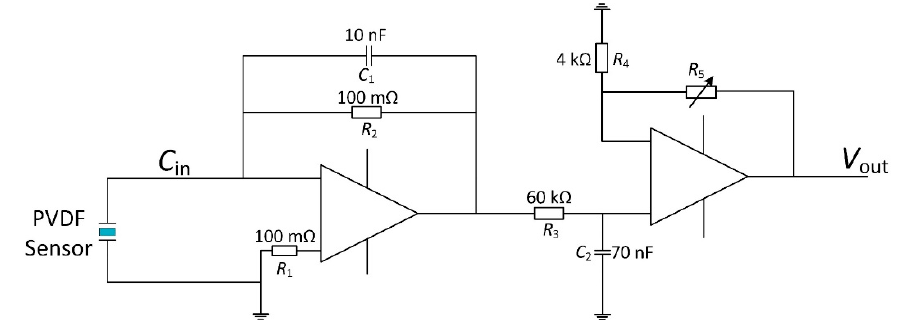
Figure 6. Electrical circuit of the sensor.